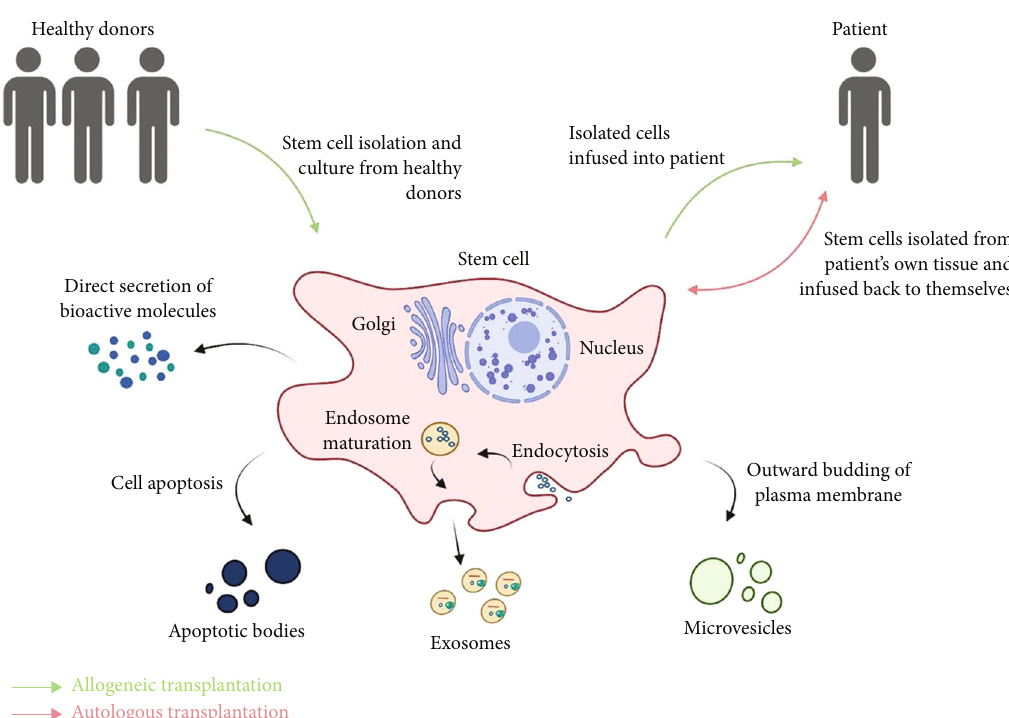
Figure 1: Classi fi cation of stem cell therapy and stem cell-derived secretome. Autologous stem cell transplantation involves the isolation of stem cells from the patient and infusion back to the same patient during treatment. Whereas in allogeneic stem cell transplantation, stem cells from single or multiple healthy donors are given to the patient. Stem cell secretome consists of bioactive molecules (including growth factors, cytokines, chemokines, enzymes, extracellular matrix) secreted directly out to the cell microenvironment or encapsulated within the extracellular vesicles that can be classi fi ed into three groups: apoptotic bodies which form during cell apoptosis, exosomes as the product of endosome maturation, and microvesicles by outward budding of the plasma membrane (created with